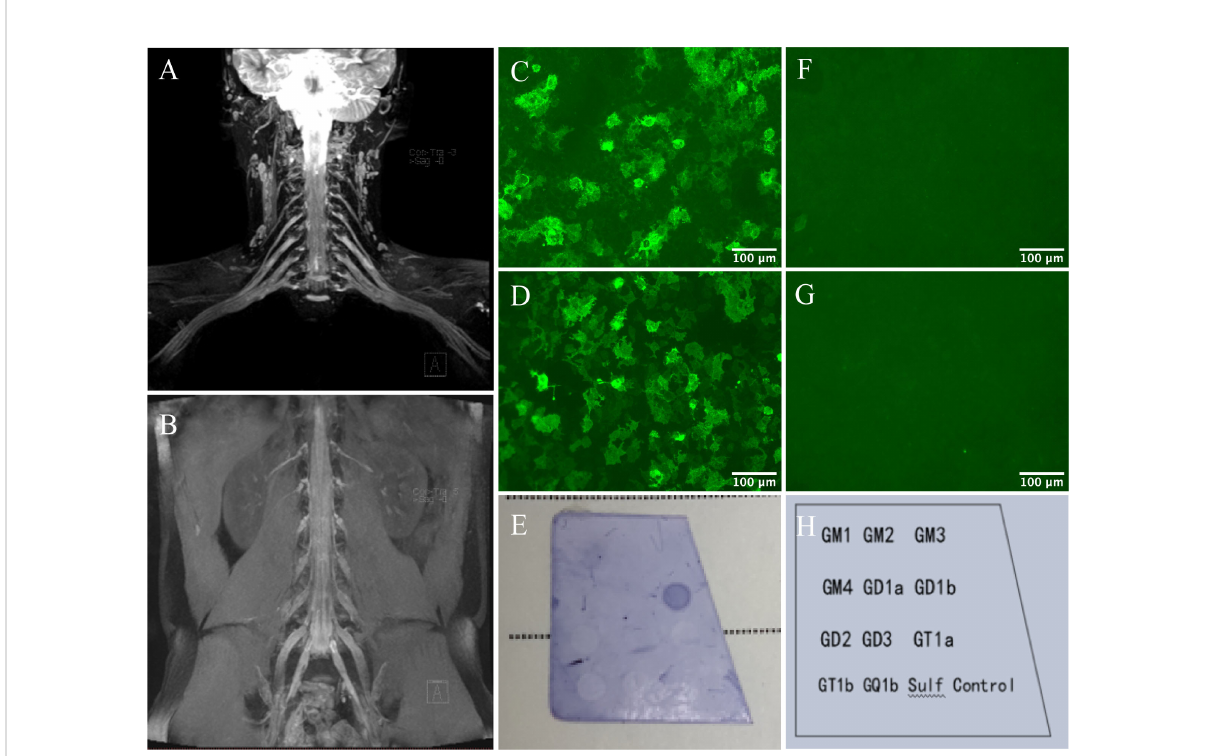
FIGURE 1 Nerve imaging and autoantibodies against NF155 and GD1b. Symmetrical bilateral enlarged cervical and lumbar plexus on MIP Thin Rage (A, B) . The presence of anti-NF155 antibodies was con fi rmed with NF155-transfected Human Embryonic Kidney (HEK) 293 cells using a cell-based assay (CBA). Reactivity was analyzed by immuno fl uorescence. Serum (C) and CSF (D) anti-NF155 antibodies were positive (×400), while negative in the control group of serum (F) and CSF (G) . Scale bar = 100 m m. The presence of anti-GD1b antibodies was con fi rmed by dot